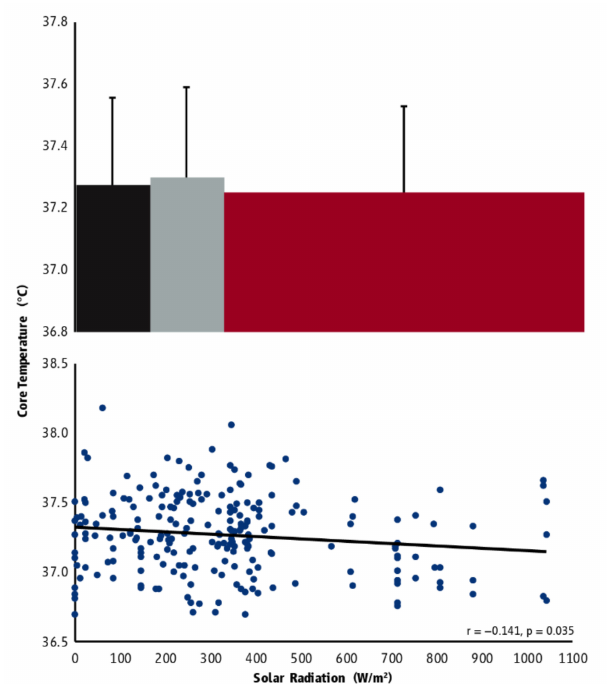
Figure A1. The average ( ± SD) core temperature in indoor (black), mixed (grey), and outdoor (red) environments characterized by the same thermal stress (top graph) as well as the association between hourly core temperature and solar radiation (bottom graph). Bar width in the top graph indicates the range of solar radiation of each category corresponding to the horizontal axis.